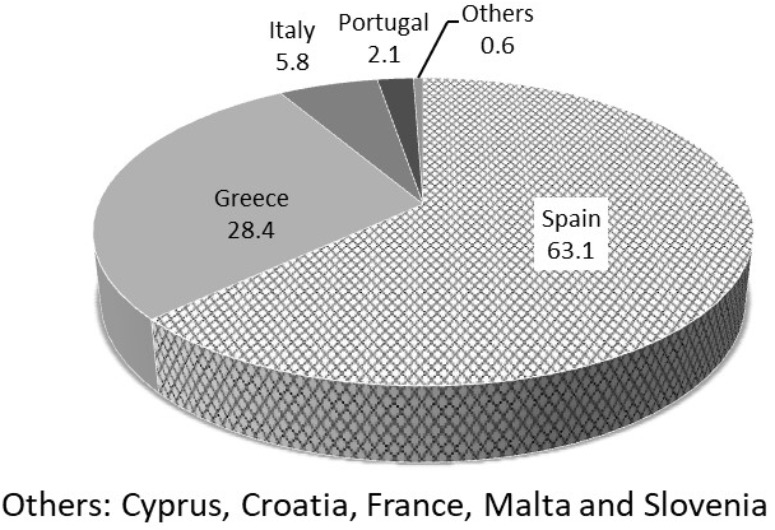
Prediction for table olive production in the EU (in percentage of the overall predicted production of 2.8 million tons for season 2017/2018) by countries. Source: International Olive Council [IOC], 2017.